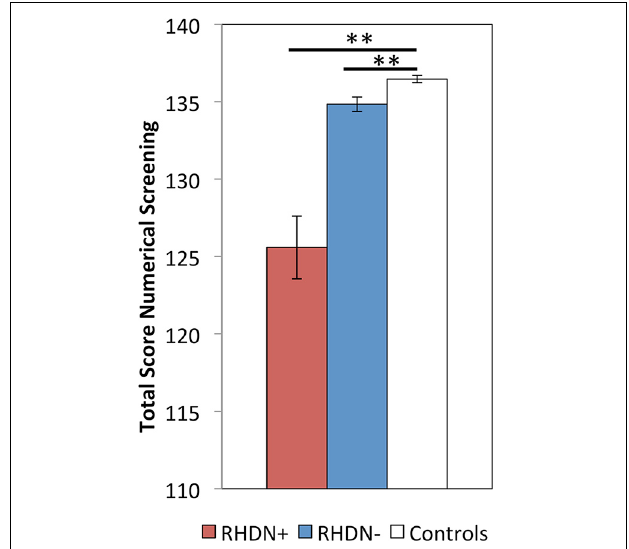
FIGURE 1 | Performance of the three groups: RHDN + , RHDN − , and healthy controls in the Numerical Screening Test. Error bars indicate standard errors of the mean. ∗∗ p < 0 .